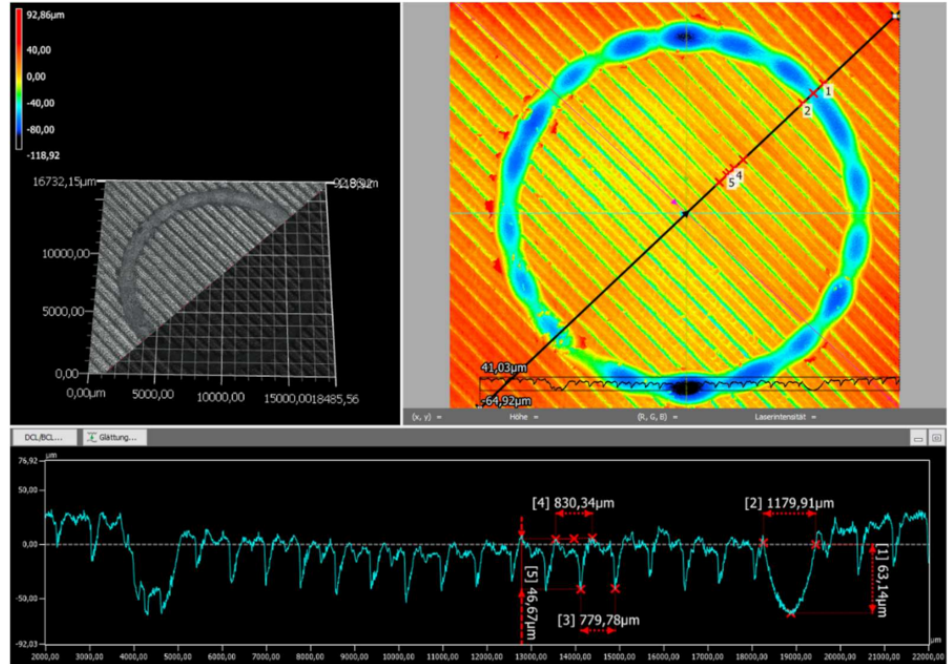
Figure 8. The wear profile of the black PLA test specimen printed at 210 ◦